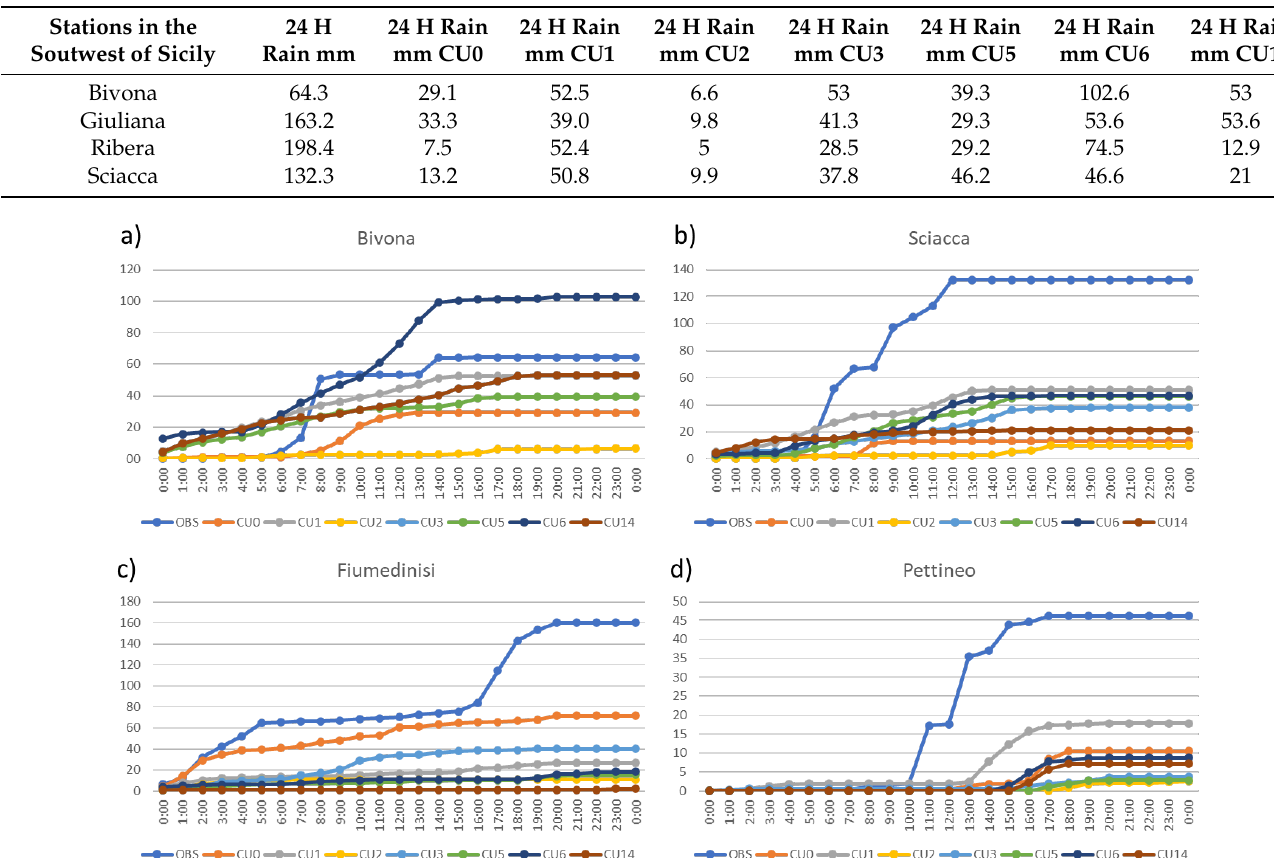
Figure 9. The hour-by-hour time series of the pluviometric data forecast and observed for the weather station. ( a ) The time series of the Bivona weather station; ( b ) the time series of the Sciacca weather station; ( c ) the time series of Fiumedinisi weather station; ( d ) the time series of the Pettineo weather station. In the graphs, the blue line represents the data observed by the weather station; the red line represents the simulation with the CU0 scheme; the green line represents the simulation with the CU1 scheme; the violet line represents the simulation with the CU2 scheme; the light blue line represents the simulation with the CU3 scheme; the orange line represents the simulation of the CU5 scheme; the dark blue line represents the simulation of the CU6 scheme; the burgundy line represents the simulation of the CU14 scheme.